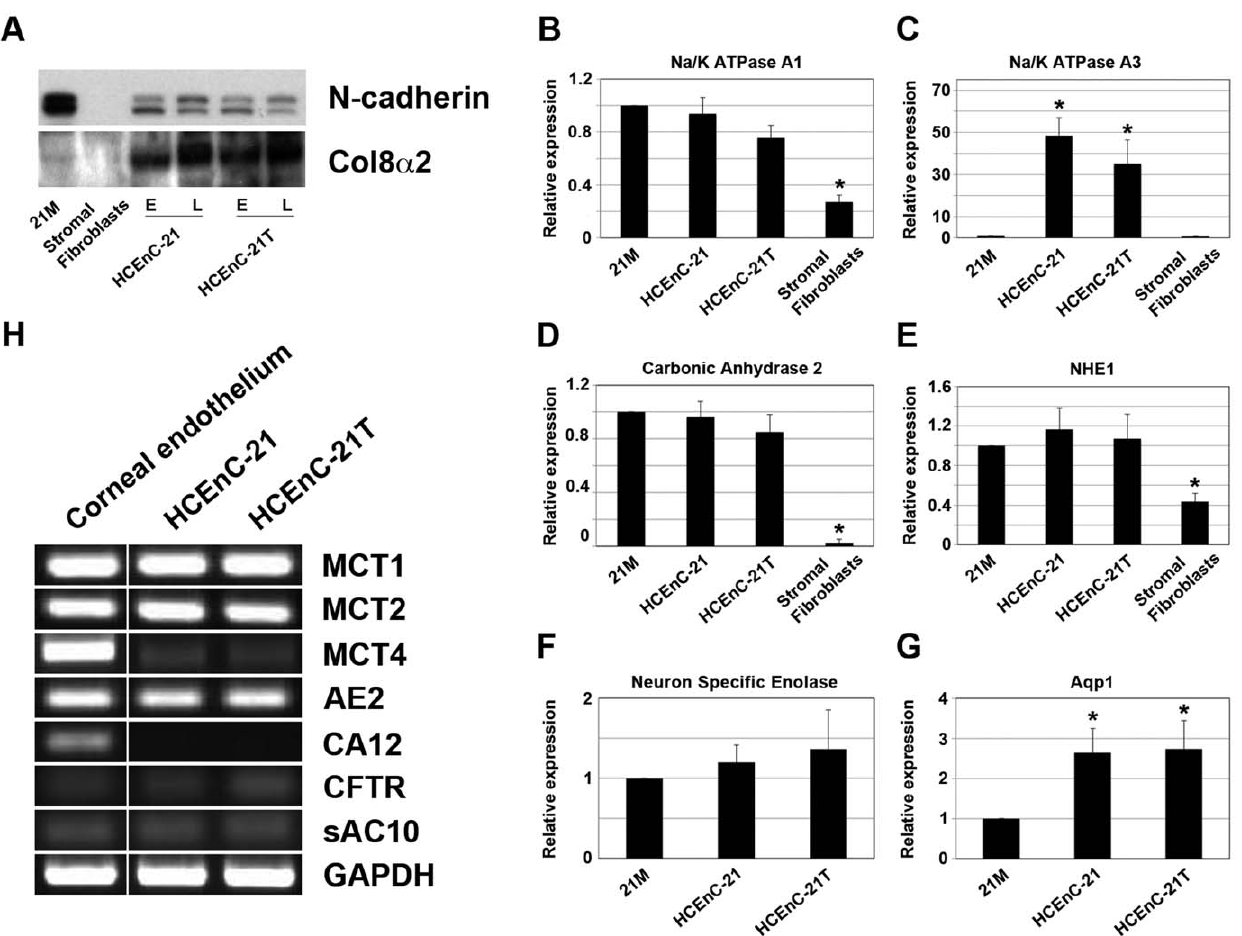
Figure 5. HCEnC-21 and HCEnC-21T cells express genes for ion pumping and typical corneal endothelial markers. (A) Cell extracts were separated by SDS-PAGE and immunoblotted for N-cadherin and collagen type 8 a 2. 21M, HCEnC-21 and HCEnC-21T, but not stromal fibroblasts, synthesized N-cadherin and Col8 a 2. E: earlier passages , 25. L: later passages . 45. (B–G) Expression of (B) Na/K ATPase a 1, (C) Na/K ATPase a 3, (D) carbonic anhydrase 2 (CA2), (E) Na/H + exchanger (NHE1), (F) neuron-specific enolase (NSE), and (G) aquaporin 1 (Aqp1) was detected by real-time PCR. Na/K ATPase a 3 and Aqp1 showed increased expression; all other genes were expressed at similar levels relative to 21M primary cells. Stromal fibroblasts expressed significantly less Na/K ATPase a 1 and a 3, NHE1, and CA2 relative to HCEnC-21 and HCEnC-21T. (H) Monocarboxylate cotransporters (MCT1, -2, and -4), anion exchanger 2 (AE2), carbonic anhydrase 12 (CA12), cystic fibrosis transmembrane conductance regulator (CFTR), soluble adenylyl cyclase 10 (sAC10), and GAPDH were detected by RT PCR. All genes, except for MCT4 and CA12, showed similar expression in HCEnC-21 and HCEnC-21T compared to corneal endothelial tissue. Error bars indicate mean 6 SEM. *, p , 0.05.